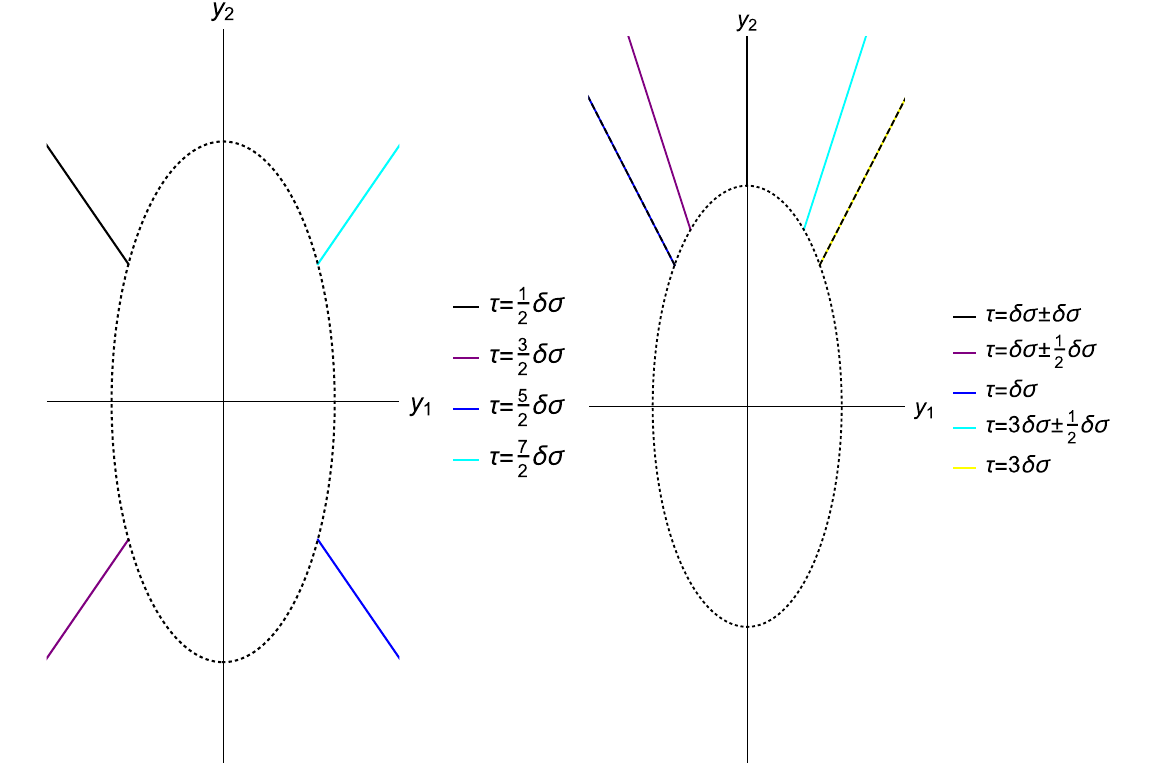
λ > 0 the angle ψ of the oscillating solution “oscillates” around π/ 2. The equation of the dotted ellipses is (87)